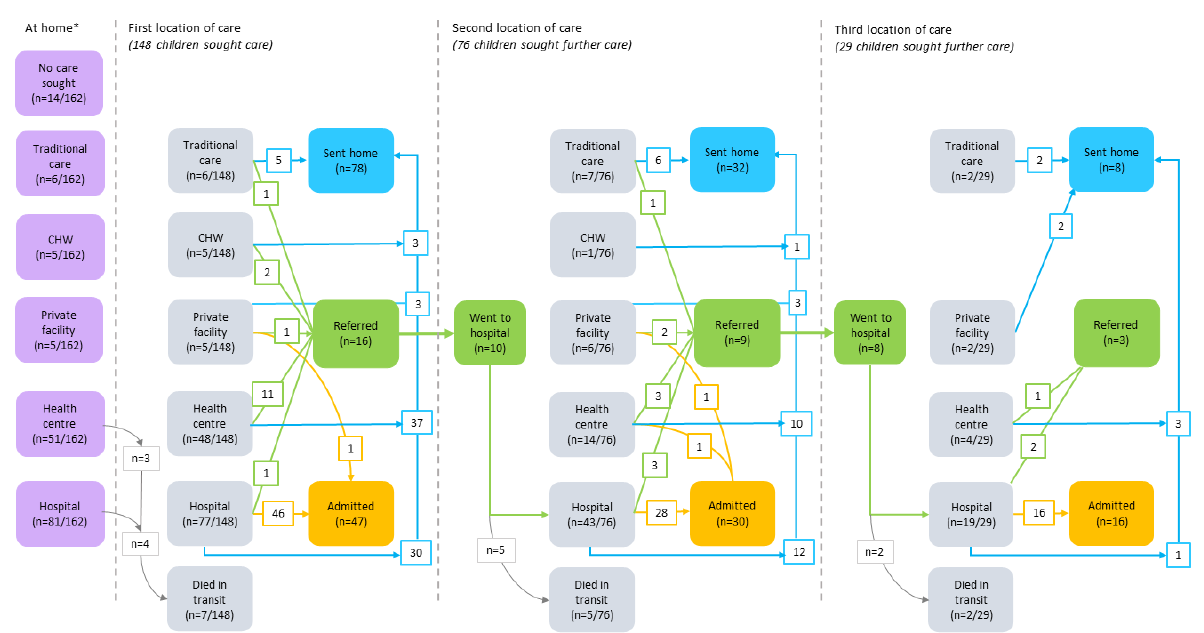
Figure 2. Summary of care-seeking according to the Pathways to Survival framework, for first, second and third